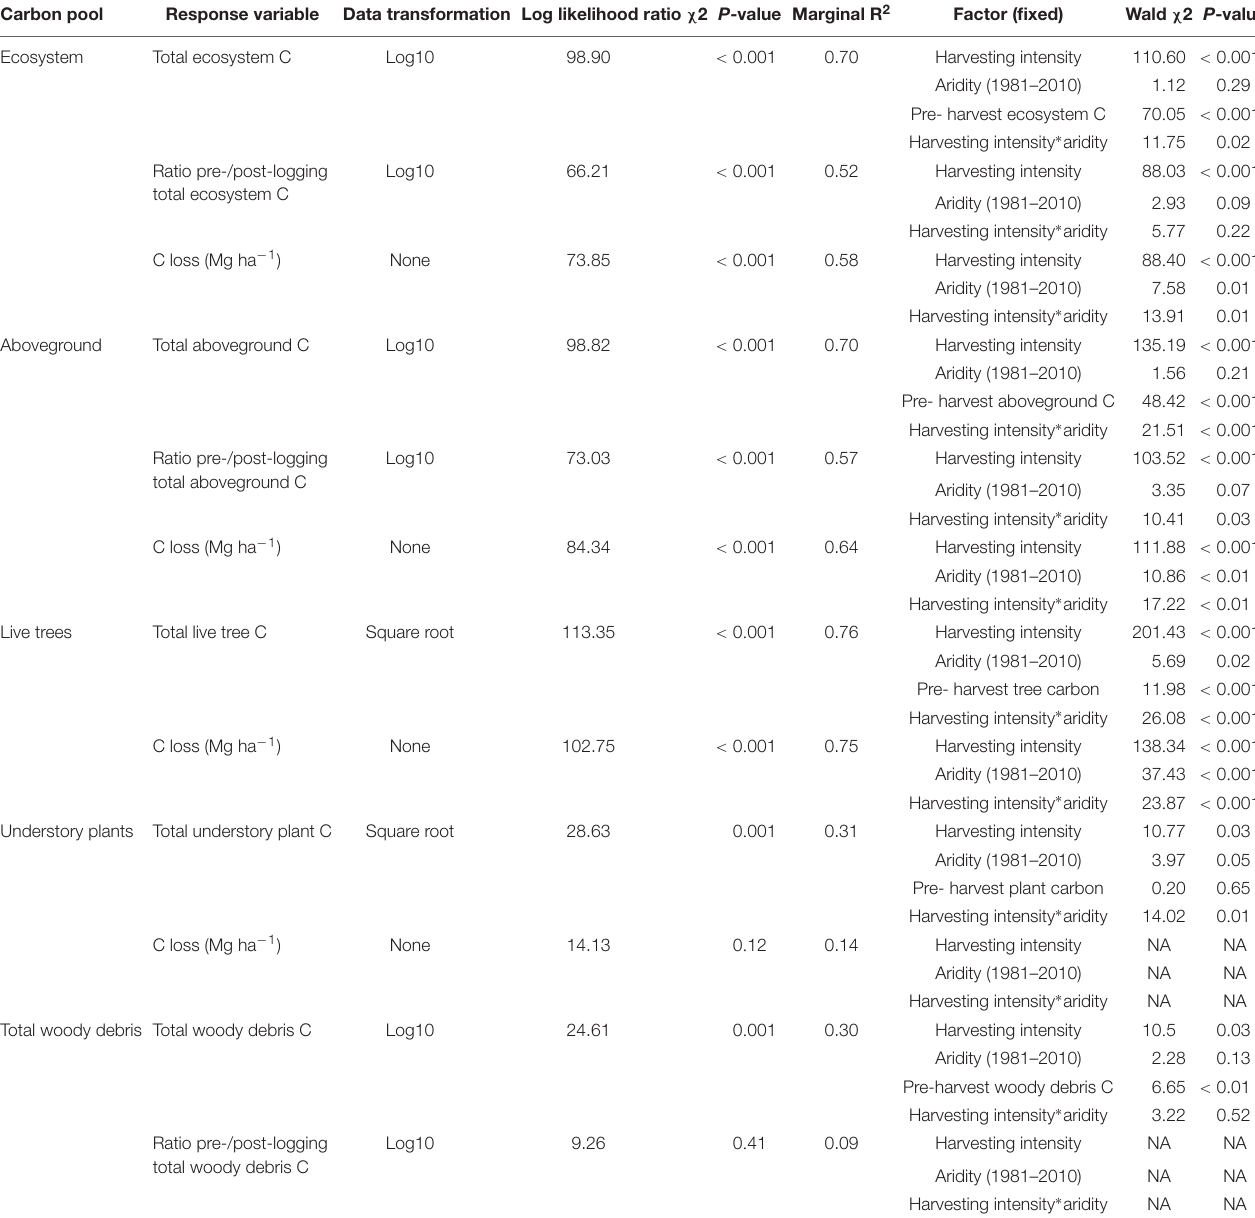
TABLE 2 | Effect of harvesting intensity and climatic aridity (1981–2000) on total ecosystem and belowground carbon storage of mixed Douglas-fir forests ( n = 3 for all locations, except Narrows Creek where n = 1, and Alex Fraser where n = 2). Carbon